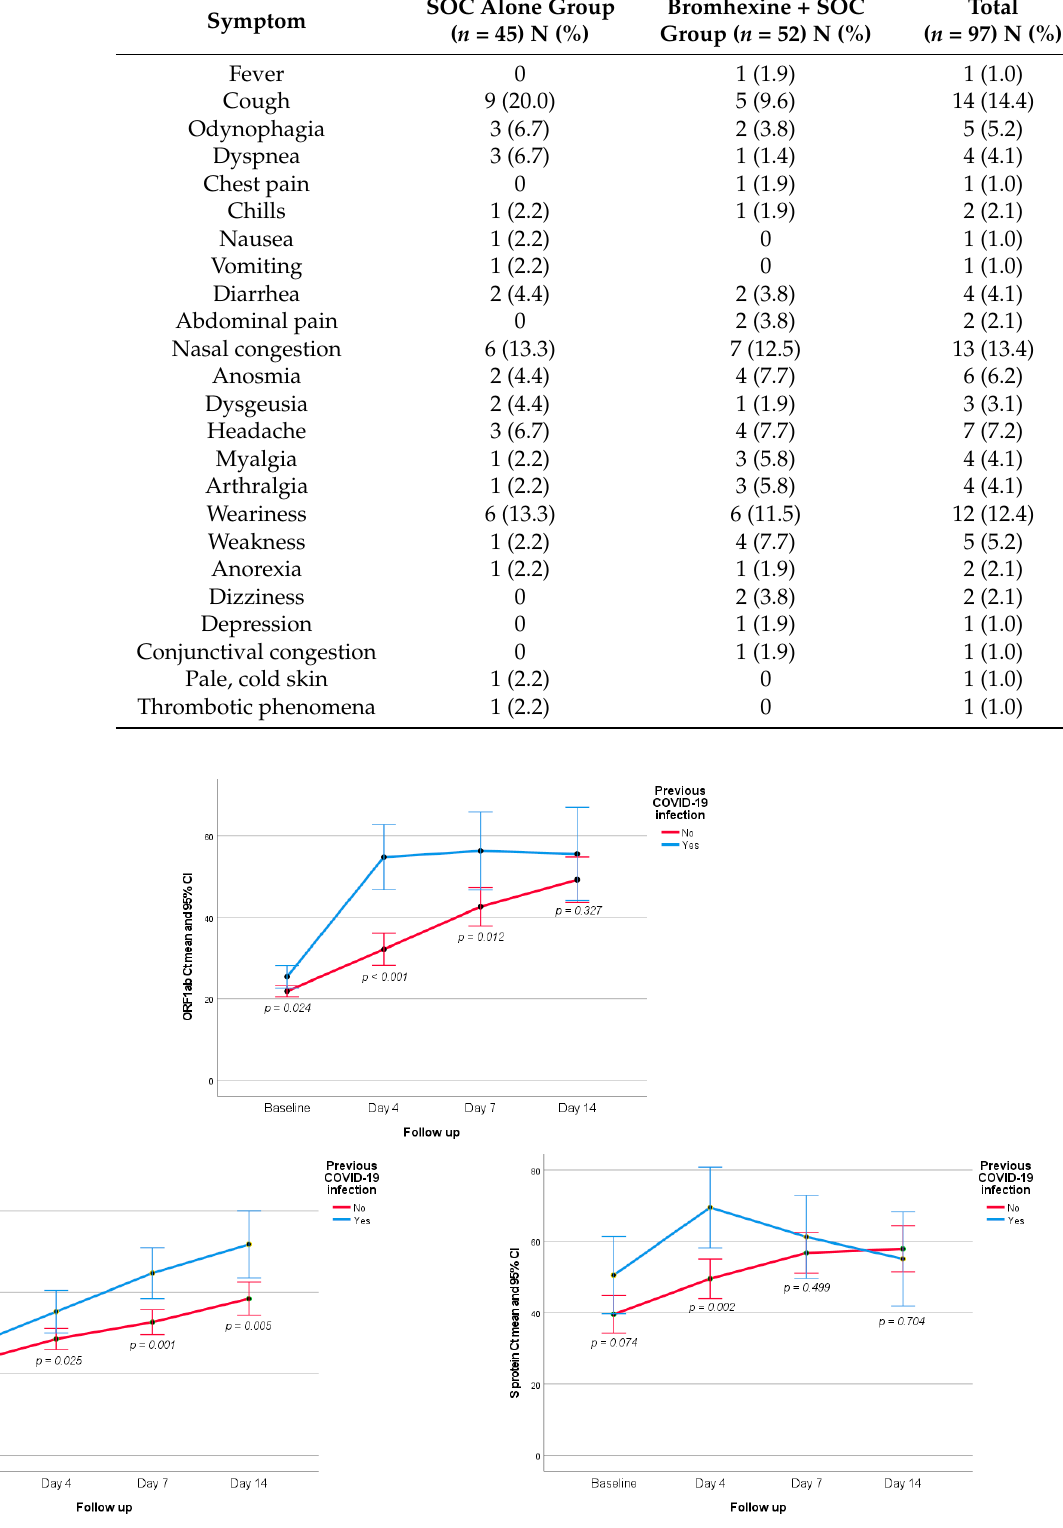
Figure 4. Evolution of ORF1ab, N Protein, and S Protein viral load according to the presence or absence of previous COVID ‐ 19 infection.